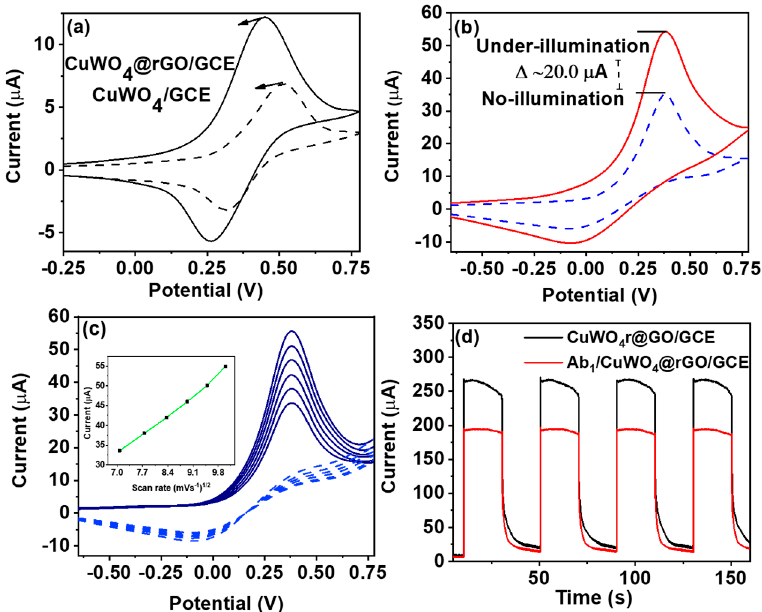
Figure 5. ( a ) CV behaviour of the CuWO 4 @rGO in reference to pristine CuWO 4 ; ( b ) electro-catalytic oxidation of ascorbic acid (AA) (0.1 mM) using CuWO 4 @rGO/GCE both under illumination and no illumination conditions; ( c ) peak current variation against scan rate in range of 50 to 100 mVs − 1 with inset depicting linearity between current response and square root of scan rate; ( d ) photo-response of CuWO 4 @rGO/GCE and Ab 1 /CuWO 4 @rGO/GCE with 30 s cut-off cycle for 150 s.